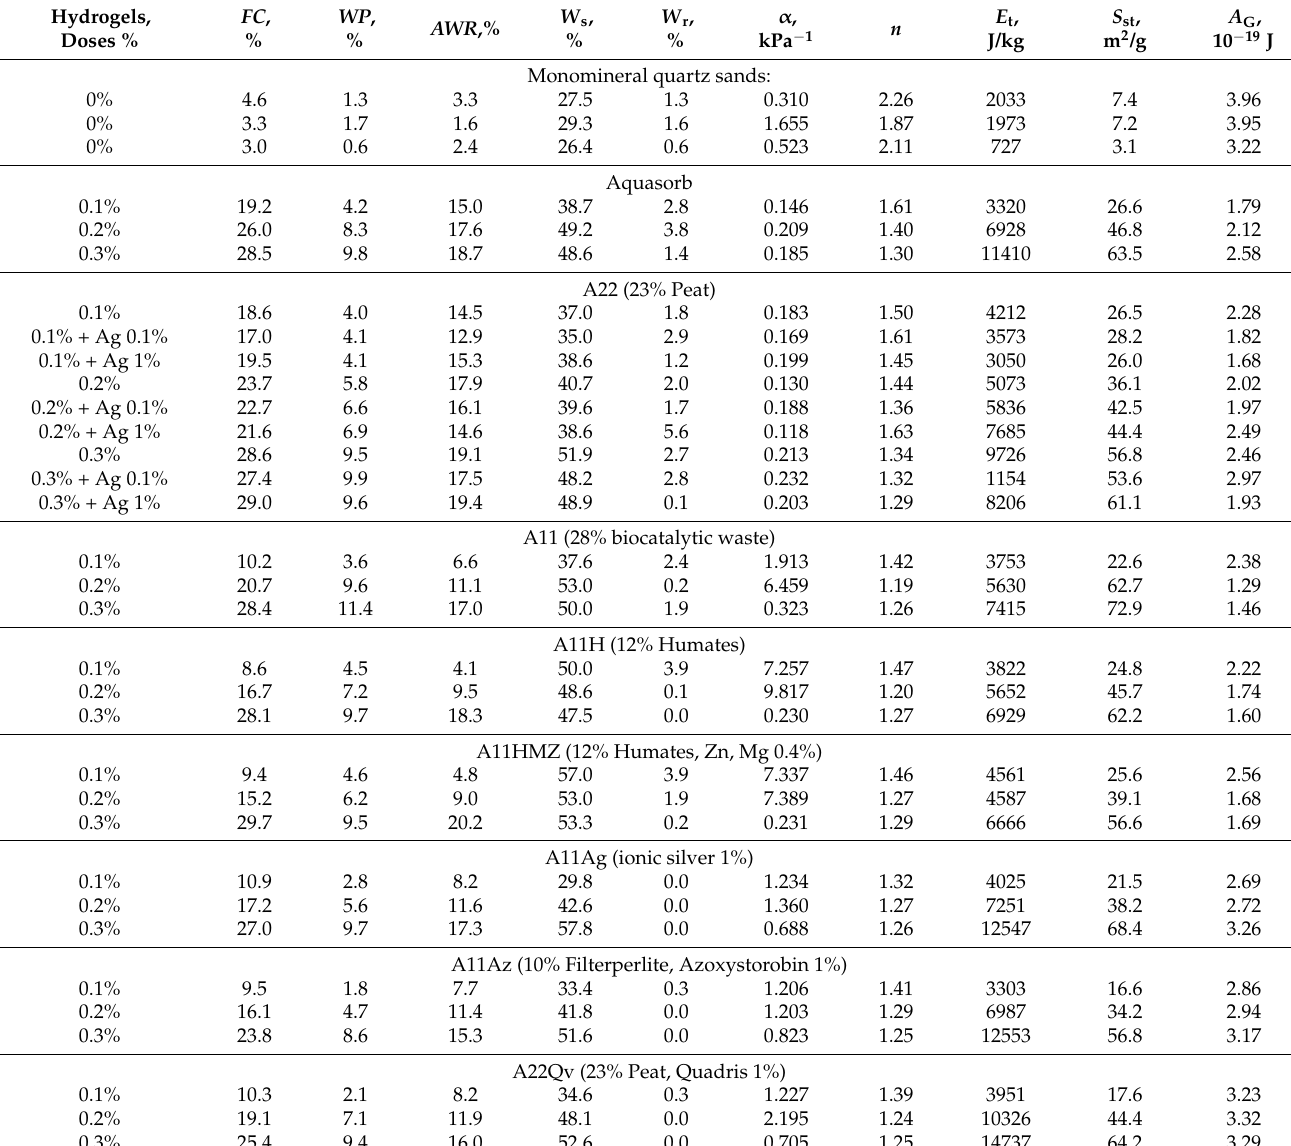
Table 5. Estimated parameters of water retention and dispersity in mineral-gel compositions with quartz